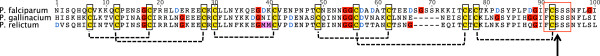
Amino acid alignment of the msp1-p19 fragment between P. relictum (SGS1) and P. falciparum (MAD20 isolate X05624.2). Dashed lines with black boxes represent conserved cysteine motifs with corresponding disulphide bonds forming, for the region, the two characteristic epithelia growth factor-like epitopes. Arrow indicates the anchor point in the merozoite membrane with the conserved “FCSS” motif surrounding the anchor point (red box).